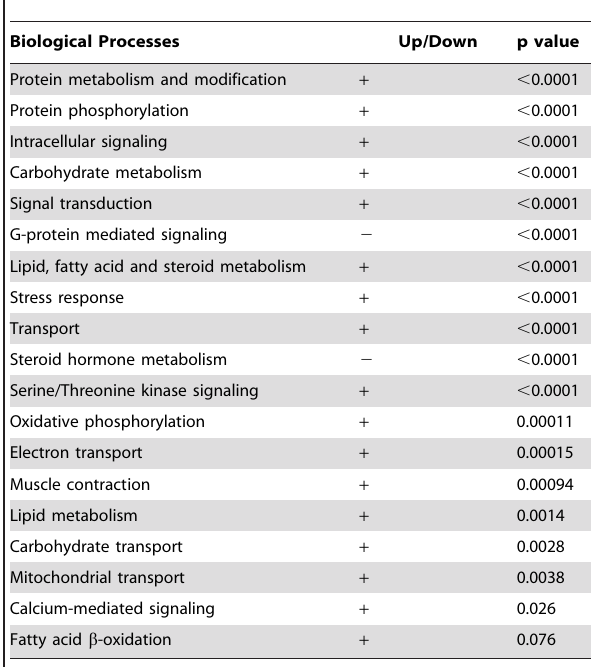
Table 1. Pathway analysis of PFI-induced gene activation in human primary